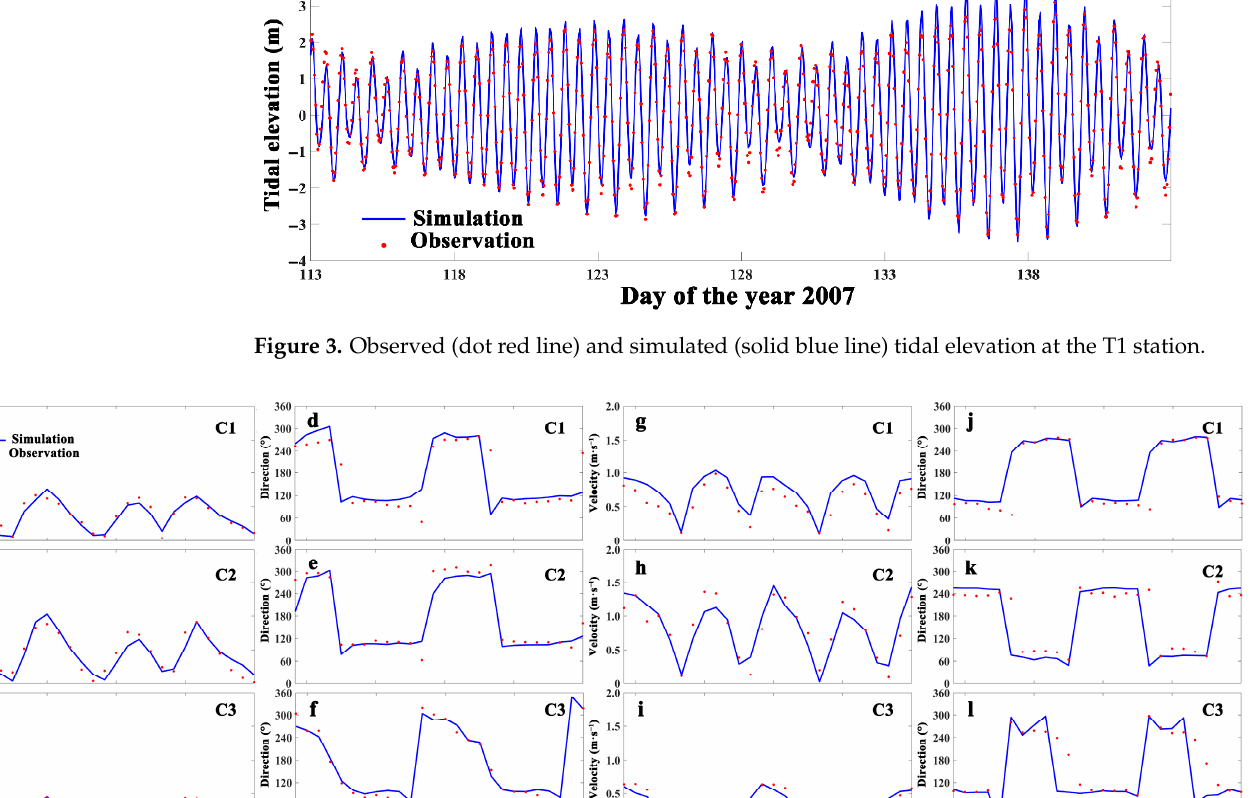
Figure 5. Observed (dot red line) and simulated (solid blue line) vertical averaged salinity (PSU) during ( a – c ) neap tide and ( d – f ) spring tide at the C1~C3 stations. Table 2. General performance ratings [49]. Performance Rating